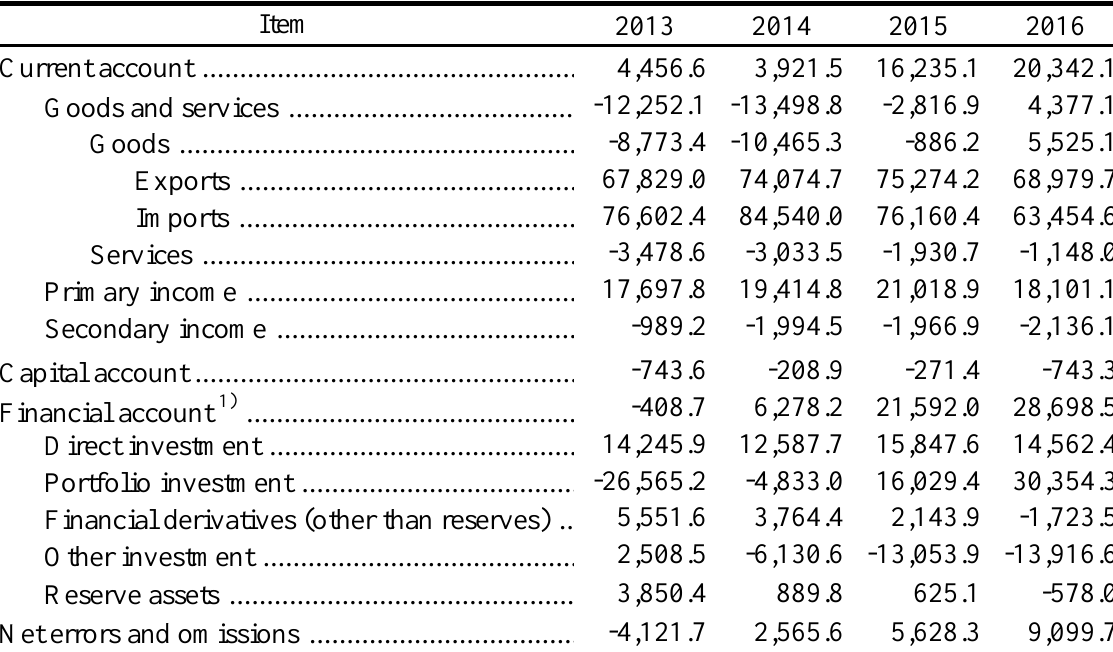
International Balance of